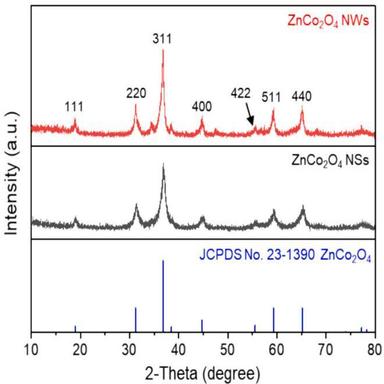
XRD patterns of ZnCo2O4 NSs and ZnCo2O4 NWs.